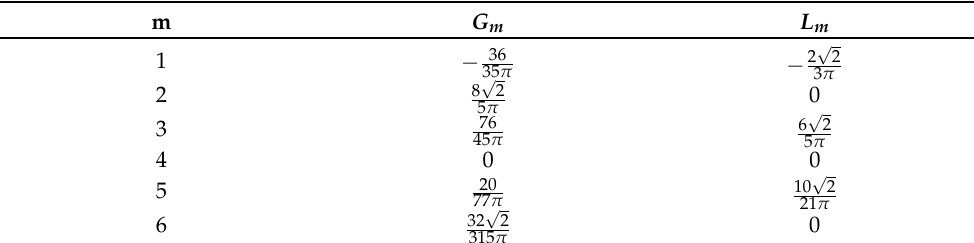
Table 2. First six values of G m , L m . see Equations